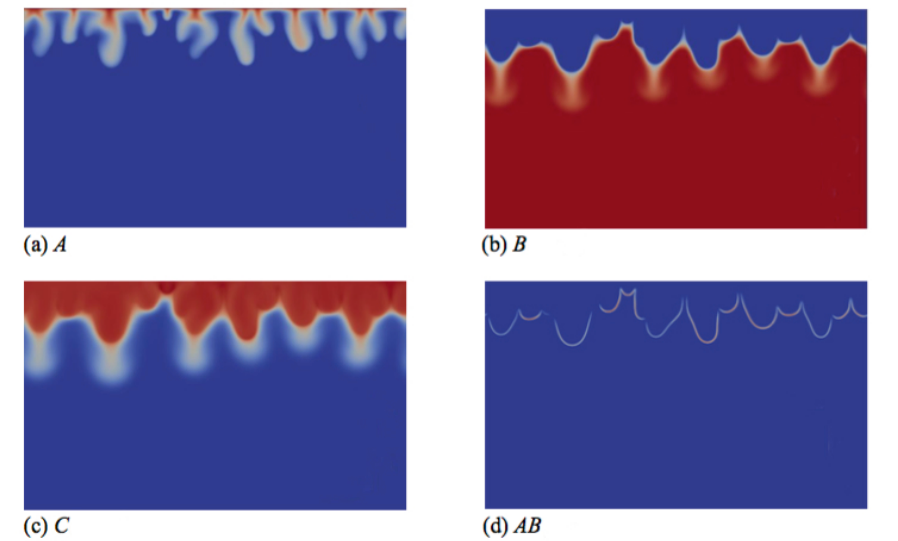
Figure 5. Concentrations fields of ( a ) A; ( b ) B; ( c ) C; and ( d ) reaction rate AB field corresponding to the density field shown in Figure 4e ( t = 20,000). Concentrations scale between zero (dark blue) and one (red), while the reaction rate scales between zero (dark blue) and 0.003